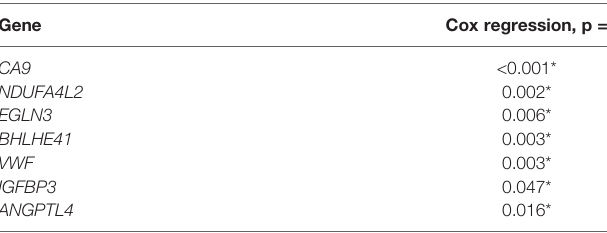
TABLE 5 | Association of gene expression with progression free survival in analysis using the Cox proportional hazards model. Gene Cox regression, p =